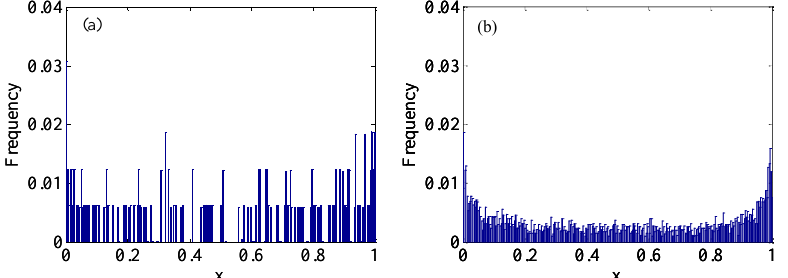
Figure 12. Histogram comparison based on different logistic maps. ( a ) The original logistic map; ( b ) The enhanced logistic